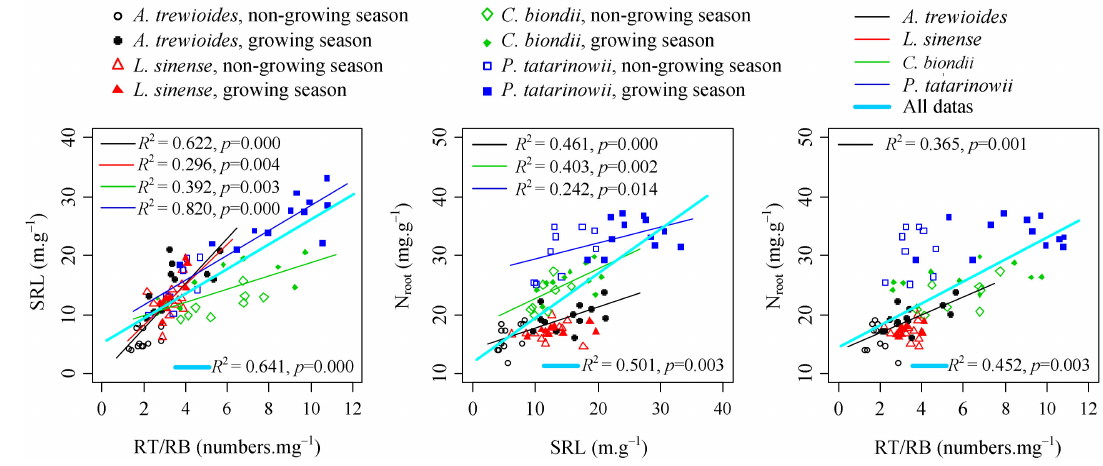
Figure 3. Relationships between specific root length (SRL), root tips over the root biomass (RT/RB), and N concentrations (N root ) in fine roots of the four study plant species in the dry and the wet season in a karst ecosystem of southwest China.